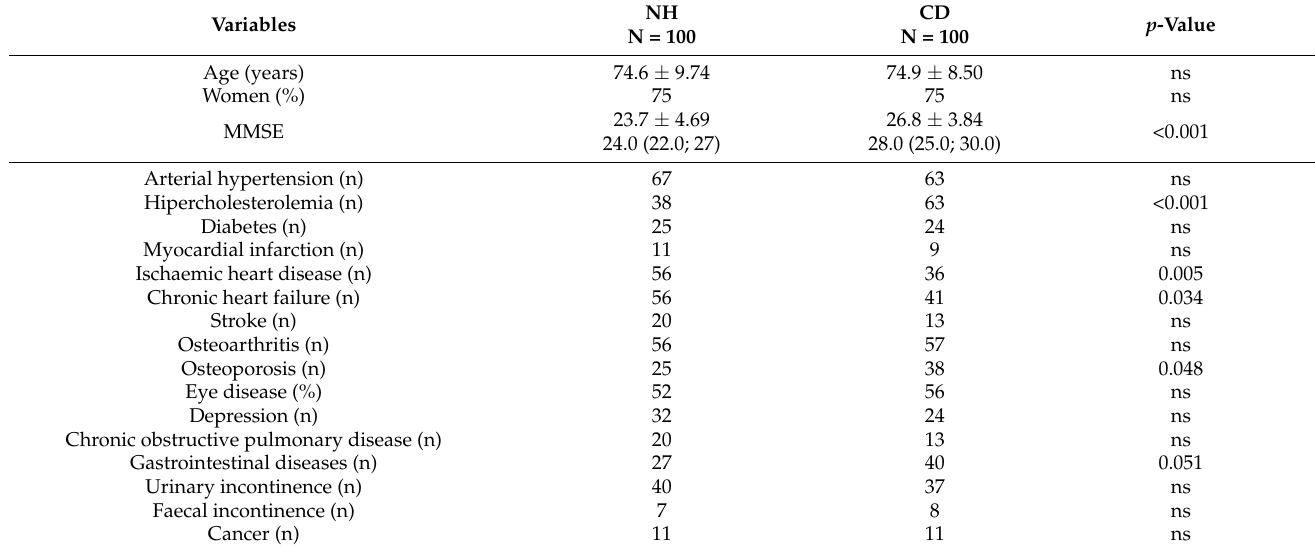
Table 1. A comparison of age, MMSE and the prevalence of chronic diseases in the two